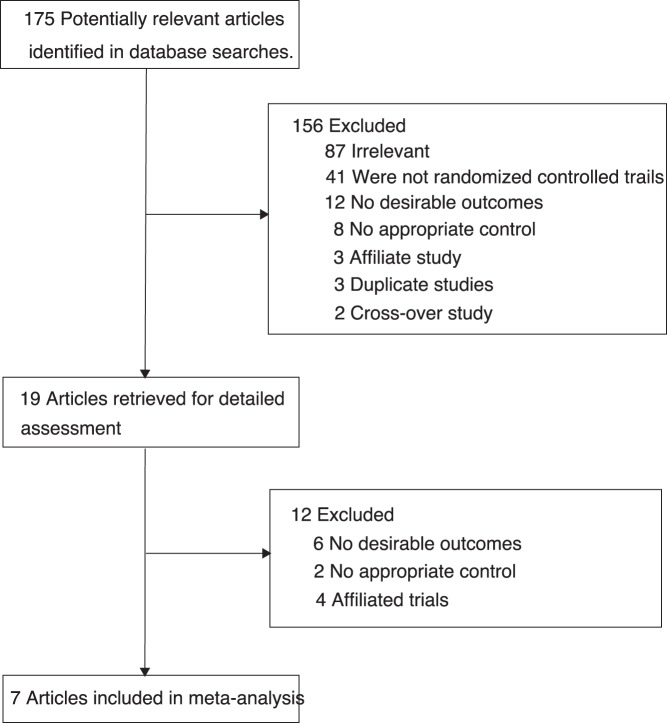
Diagram of the literature search and tria selection process.